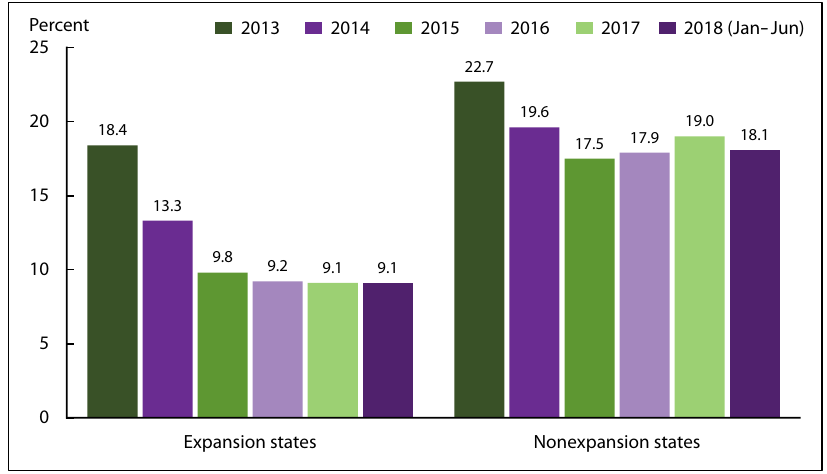
Figure 9. Percentage of adults aged 18–64 who were uninsured at the time of interview, by year and state Medicaid expansion status: United States, 2013–June